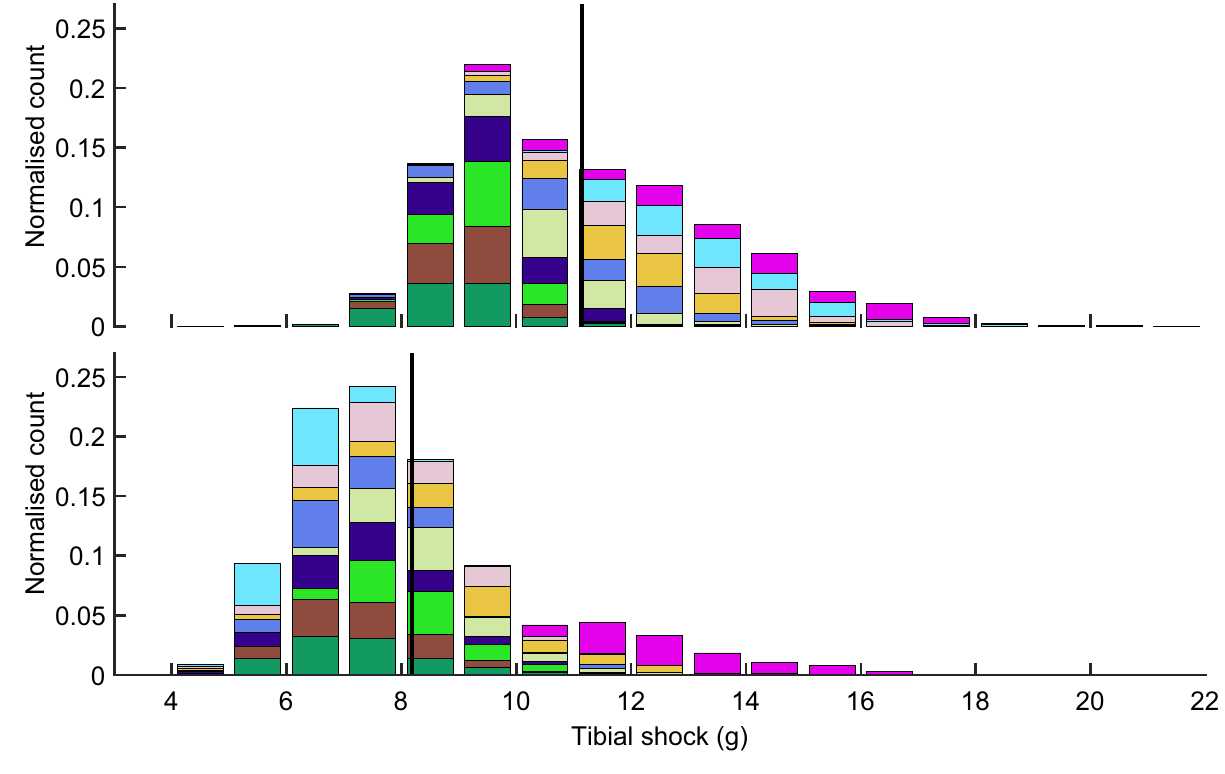
Figure 5. Histogram of the tibial shock magnitudes in the analysis period for the [upper panel] no feedback condition and the [lower panel] biofeedback condition. Each color represents a participant (n = 10). The number of footfalls within a single bin has been normalized to the total number of detected footfalls in that condition. The solid vertical line indicates the tibial shock averaged for all footfalls in that